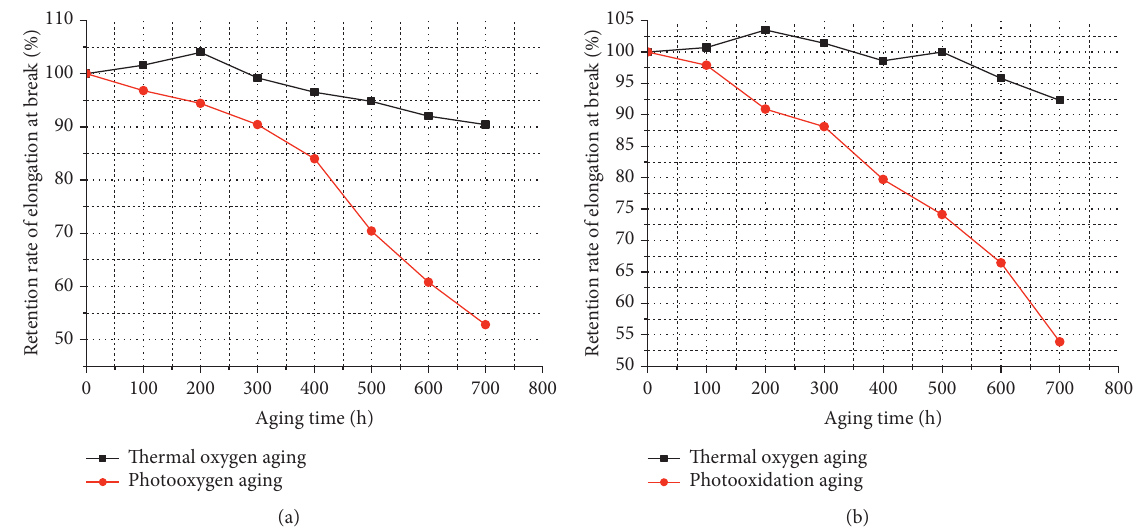
Figure 9: Relationship curves of retention rate of elongation at break-aging time. (a) BG1. (b)